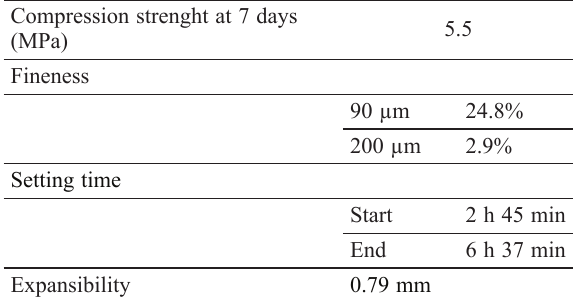
Table 1. Natural hydraulic lime characteristics